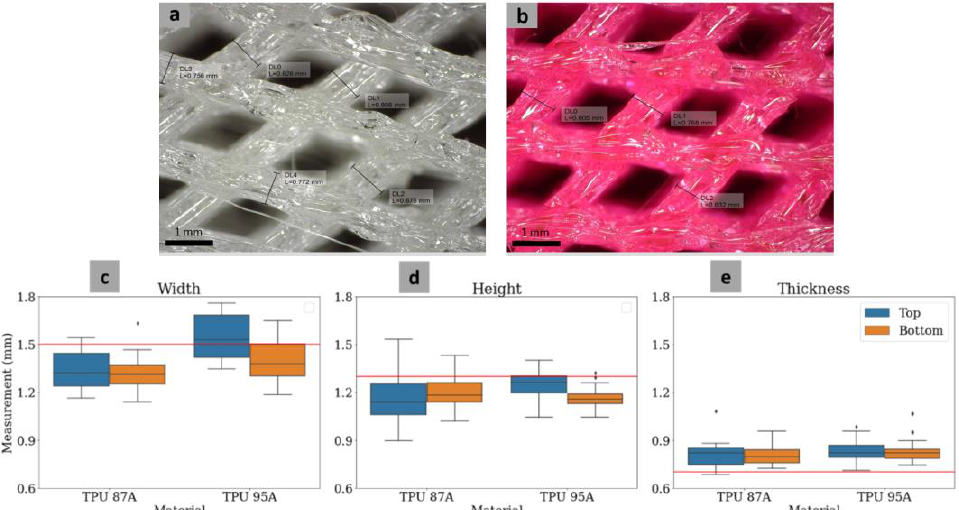
Figure 6. Representative photographs of the geometrical evaluation of MTDR TPU 87A ( a ) and TPU 95A ( b ). Boxplots of the measurements of the hole width ( c ), hole height ( d ), and strut thickness ( e ).